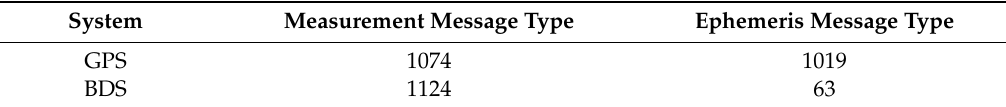
Table 3. Results of different algorithms under multipath environment.